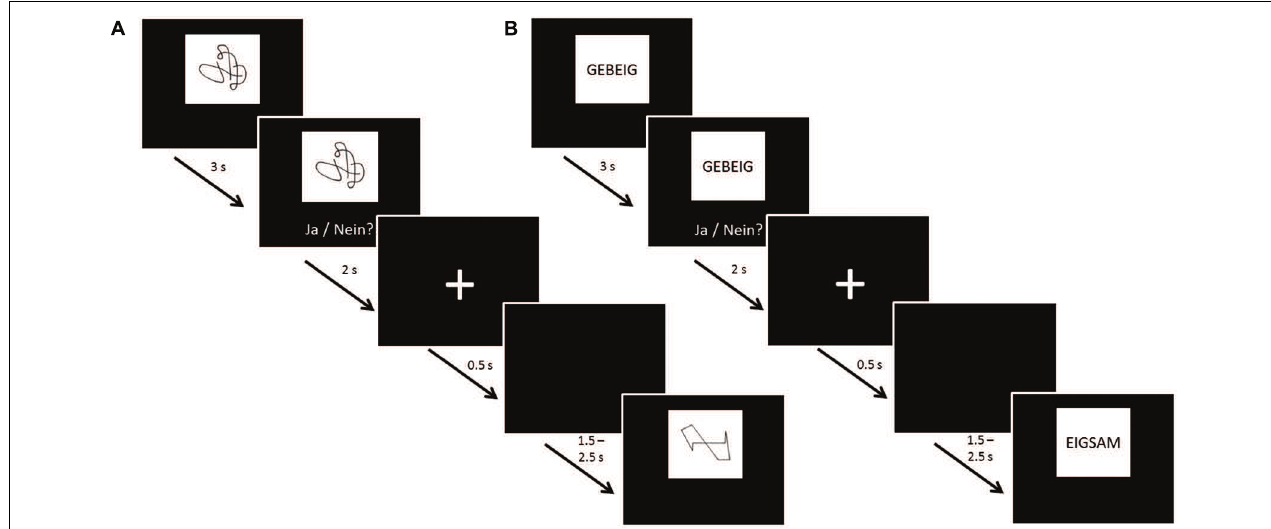
FIGURE 1 | Task procedure of the (A) non-verbal learning task (NVLT) and (B) verbal learning task (VLT). After 3 s of stimulus presentation, participants were shown the stimulus and the question “Ja/Nein?” [German for “Yes/No”] for 2 s, asking them to indicate by button press whether they had seen the stimulus before. Then, a fixation cross was shown for 0.5 s. Before the next stimulus presentation, a black screen was shown for a jittered duration of 1.5–2.5 s to avoid expectation effects of the participants.